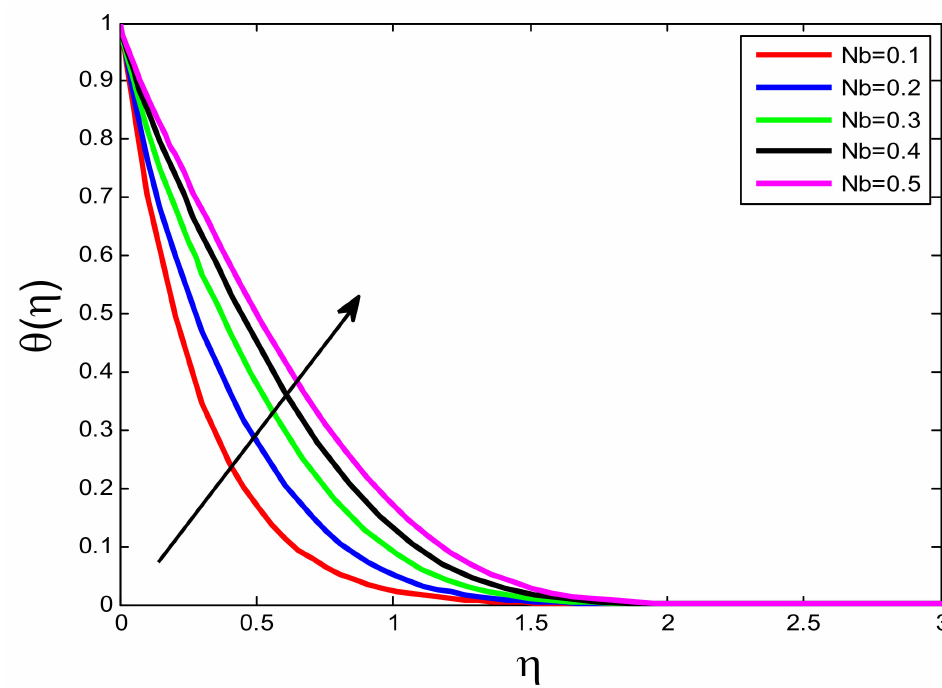
Figure 19. Influence of Nb on θ ( η )